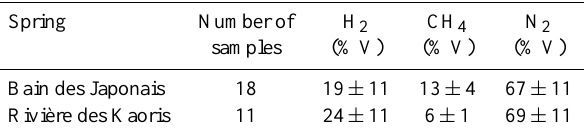
Table 3. The hydrogen, methane and nitrogen contents of the gases (in volumetric percentage) collected at the springs of the Bain des Japonais and of the Rivière des Kaoris. Spring